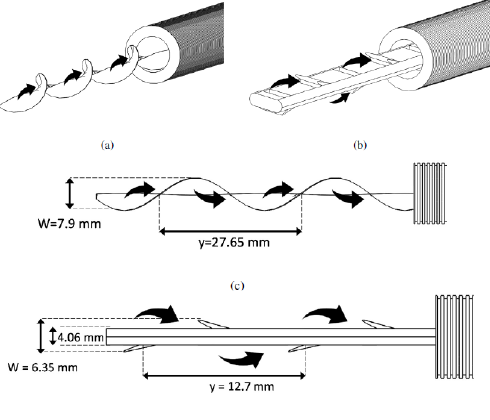
Fig. 3. Schematic of turbulators: a, c) twisted tape; b, d) Z-type